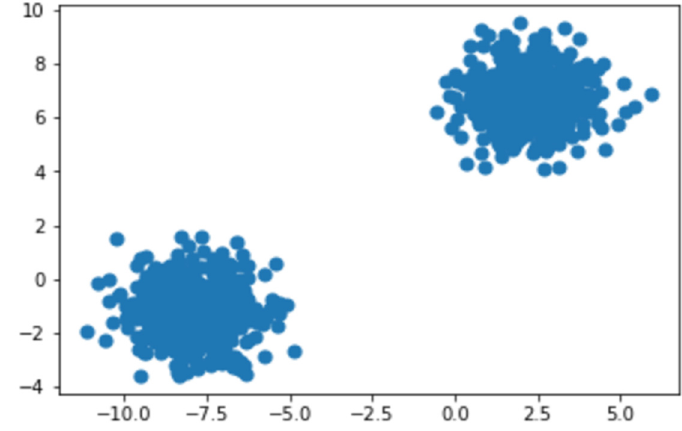
Figure 11. Clusters identified by K-means algorithm.